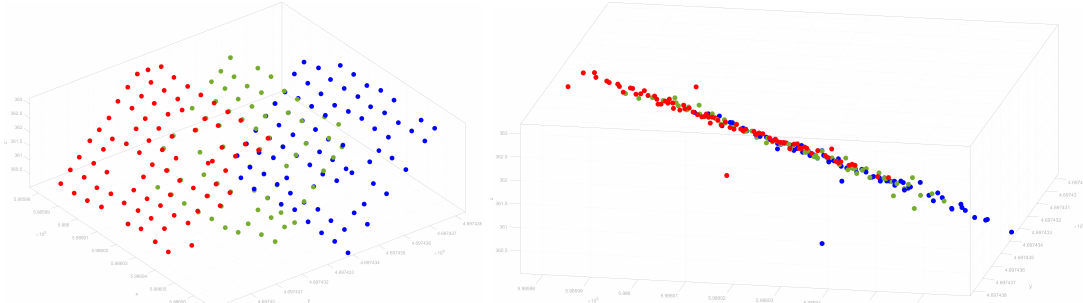
Figure 2. Three consecutive Single Photon LiDAR point measurements (red, green, blue) indicating the regular scan grid caused by the 100beamlets per laser pulse; ( left ) oblique 3D view of the point cloud, ( right ) profile view of the same point